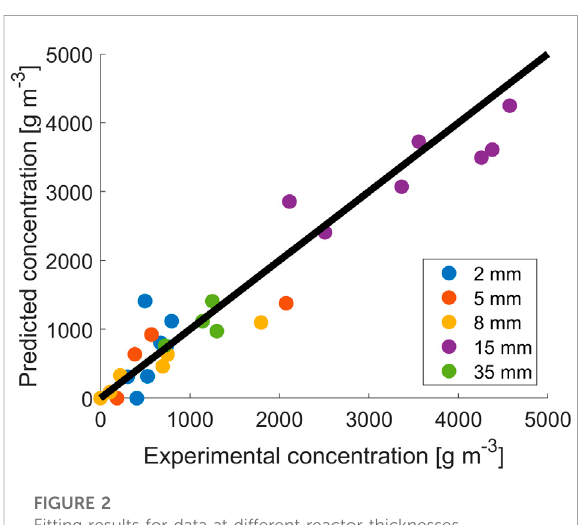
FIGURE 2 Fitting results for data at different reactor